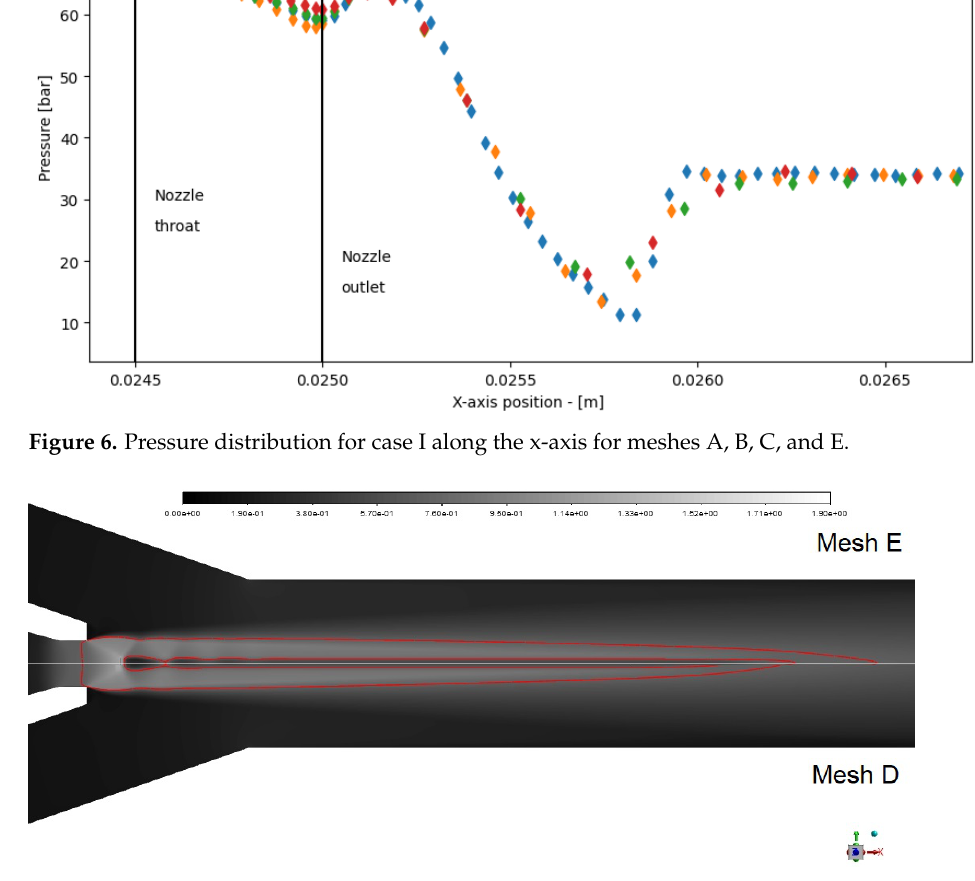
Figure 7. Mach number distribution for meshes E ( top ) and D ( bottom ) for case IV. Red line illustrates Mach 1.